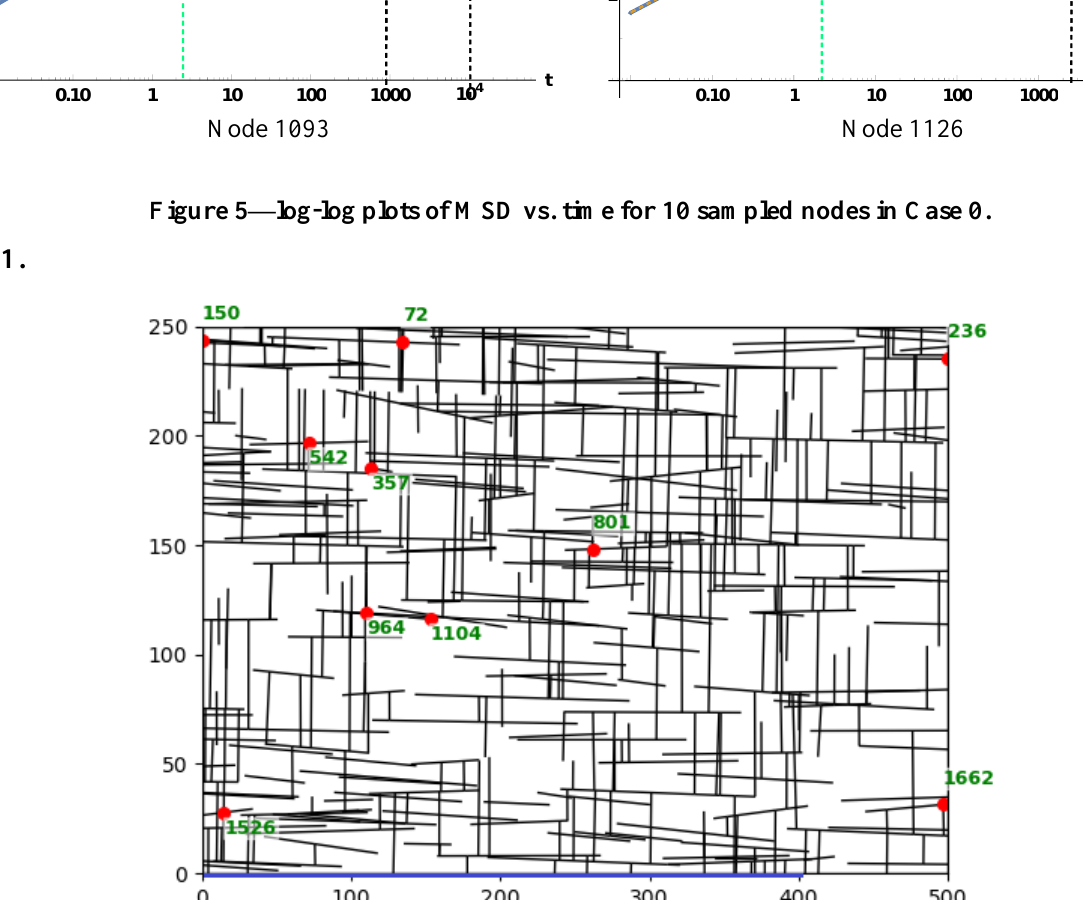
Figure 6—Map view plot of the fracture network and 10 sampled nodes in Case 1.